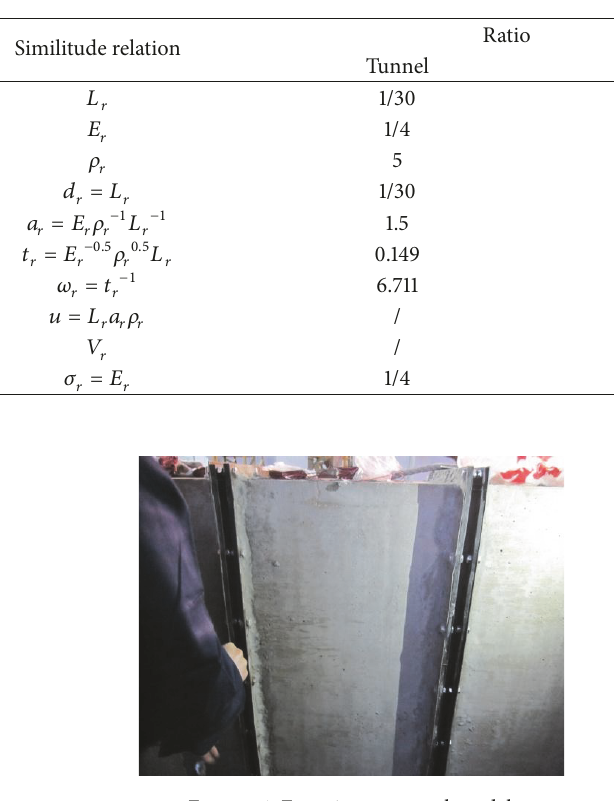
Table 1: Similitude relations and ratios of the model system.